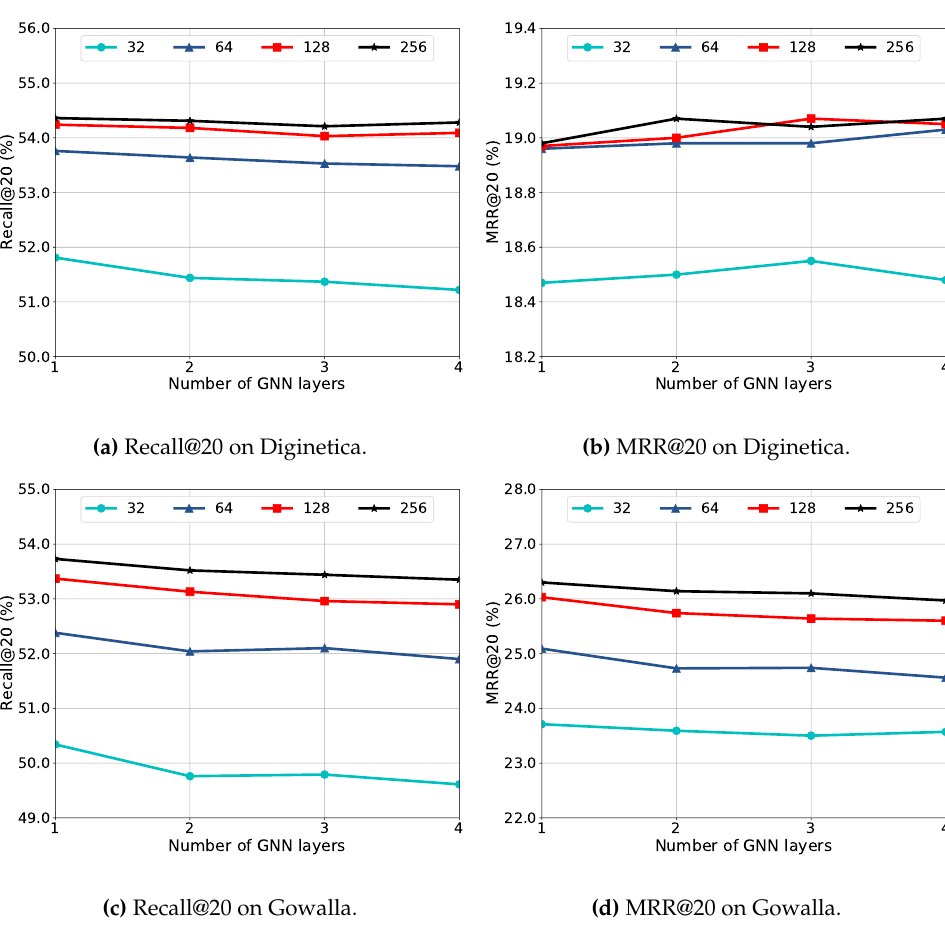
Figure 5. Hyper-parameter